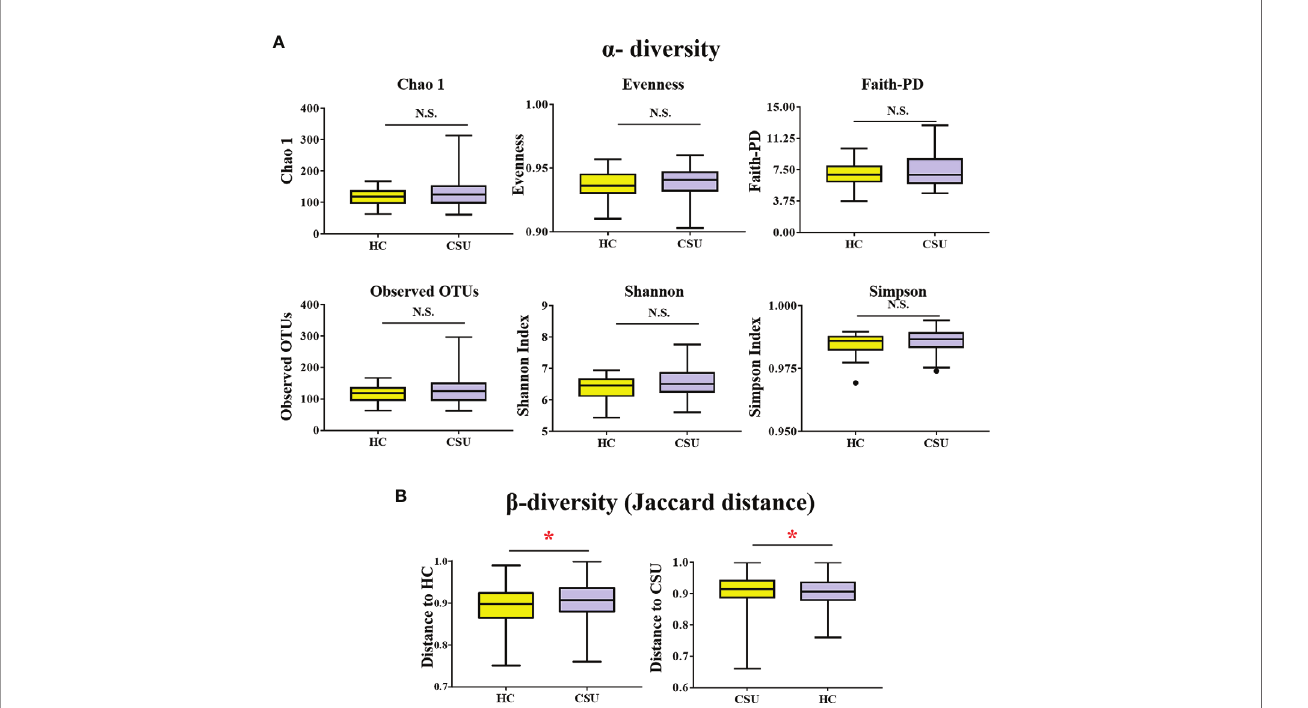
FIGURE 1 | Comparing the diversity of the gut microbiota of patients with chronic spontaneous urticaria (CSU) and healthy controls (HCs). (A) The a -diversity of CSU patients and HCs was measured with the Chao 1 index, evenness, Faith ’ s phylogenetic diversity (PD), observed operational taxonomic units (OTUs), Shannon index, and Simpson index. There was no difference in a -diversity between the two groups ( p > 0.05). (B) Group differences in b -diversity (Jaccard distance index) with respect to CSU patients and HCs. Statistical analyses were performed using PerMANOVA (* p < 0.05). N.S., not signi fi